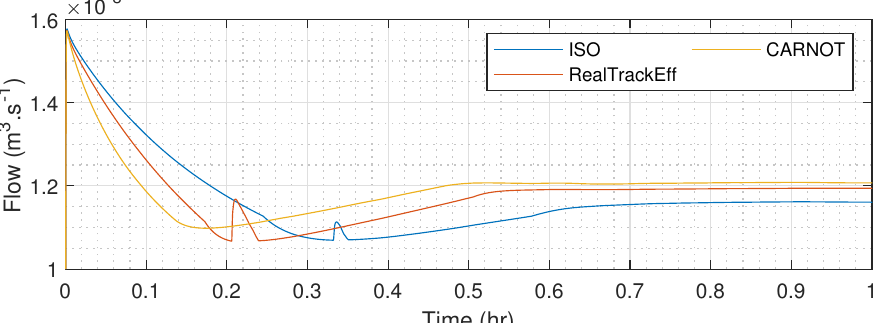
Figure 14. Flow of the HTF with the 3